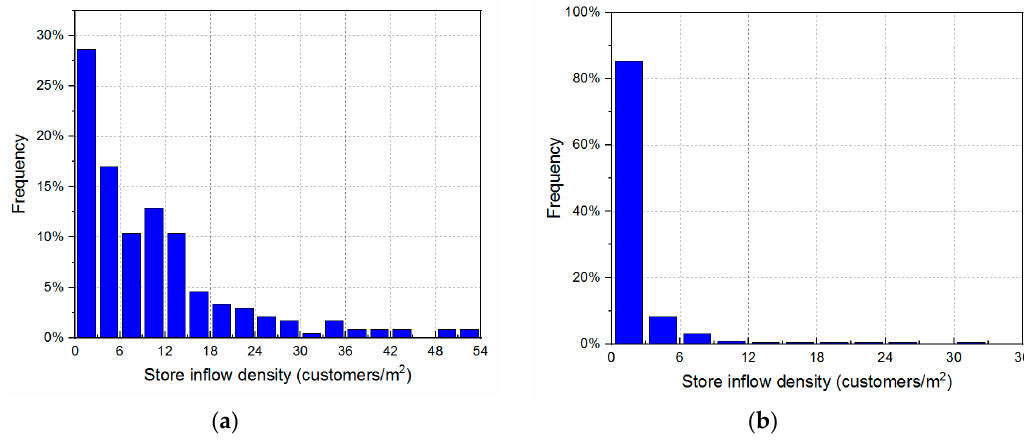
Figure 9. Histogram of store inflow density. ( a ) DYC; ( b ) LH.